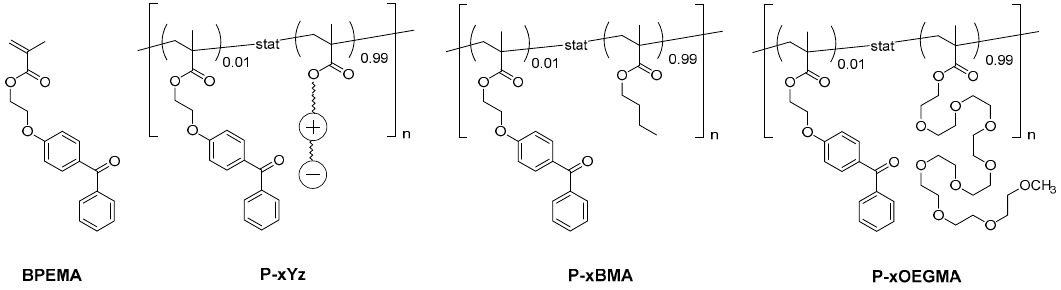
Figure 3. Chemical structure of the photo-reactive comonomer BPEMA used, the photo-crosslinkable copolymers P–xYz (with Y = 1 − 6 and z = a − d; see also Figure 1), and of the reference